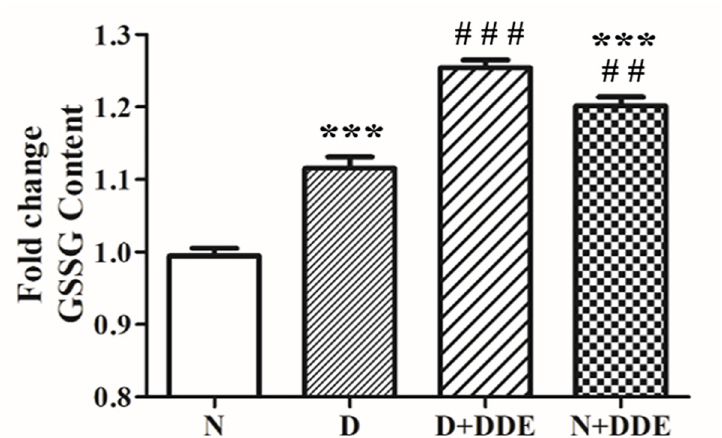
Fig 5. GSSG hepatic content. The level of GSSG was evaluated on total liver homogenate. Significant of differences is shown: ��� p < 0 . 001 vs. N; ## p < 0 , 01 vs. D; ### p < 0 . 001 vs. D.